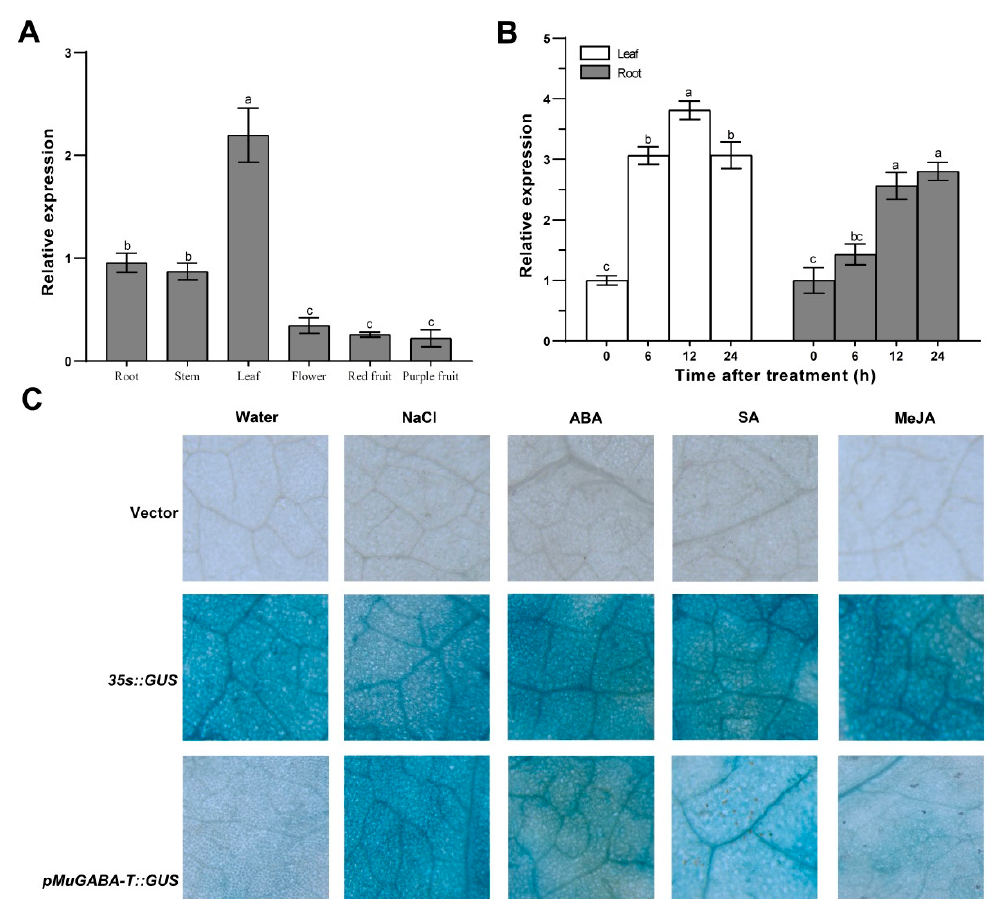
Figure 4. Expression pattern of MuGABA-T gene. ( A ) Expression pattern of MuGABA-T gene in different tissues. ( B ) Salt-stress-induced expression pattern of MuGABA-T gene in leaves and roots. The relative expression levels of MuGABA-T were calculated using the 2 − ∆∆ Ct method, and the Actin gene was used as a reference gene. Values represent the average of three biological replicates ± SD. Different letters above the columns indicate that the means in this column are significantly different ( p < 0.05) according to Duncan’s multiple range test. ( C ) Transient expression pattern of MuGABA-T gene in N. benthamiana leaves. The leaves were infiltrated with the transformed Agrobacterium strains and sampled at 48 h after treatment with ABA, SA, MeJA or NaCl.